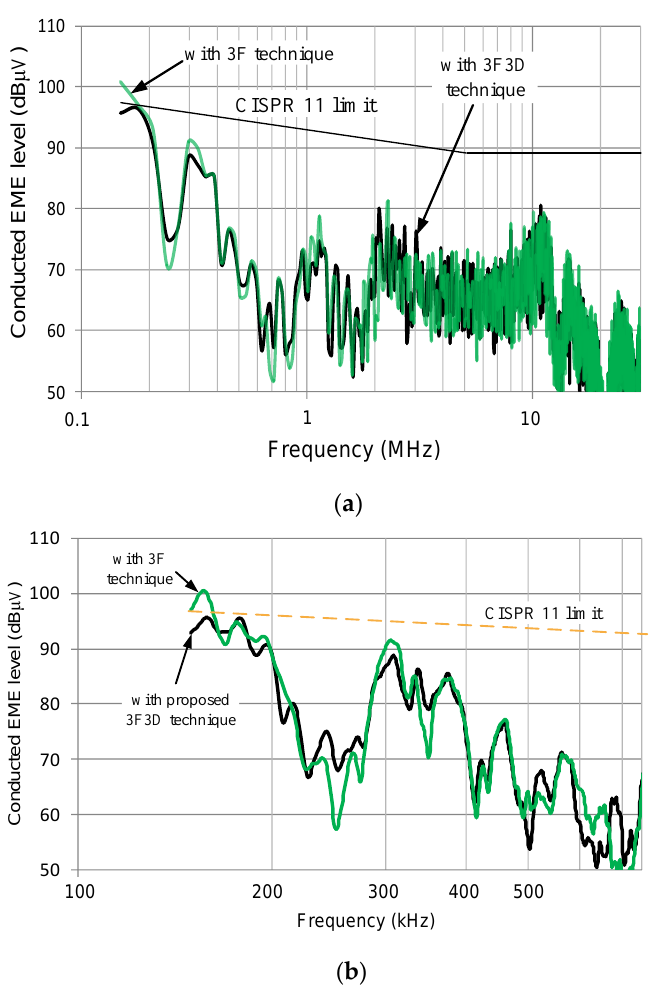
Figure 12. Comparison of spectra of the conducted EME from the WPT system with the spread spectrum based on 3-frequency technique and based on the proposed 3F3D spread spectrum technique: ( a ) within frequency range 0.15–30 MHz; and ( b ) within frequency range 0.15–0.8 MHz. Note: other parameters are the same as those in Figure 10. Table 2. The first and the second harmonic amplitude reduction coefficients ( A EME1 and A EME2 ) and the efficiencies ( η ) for different cases.